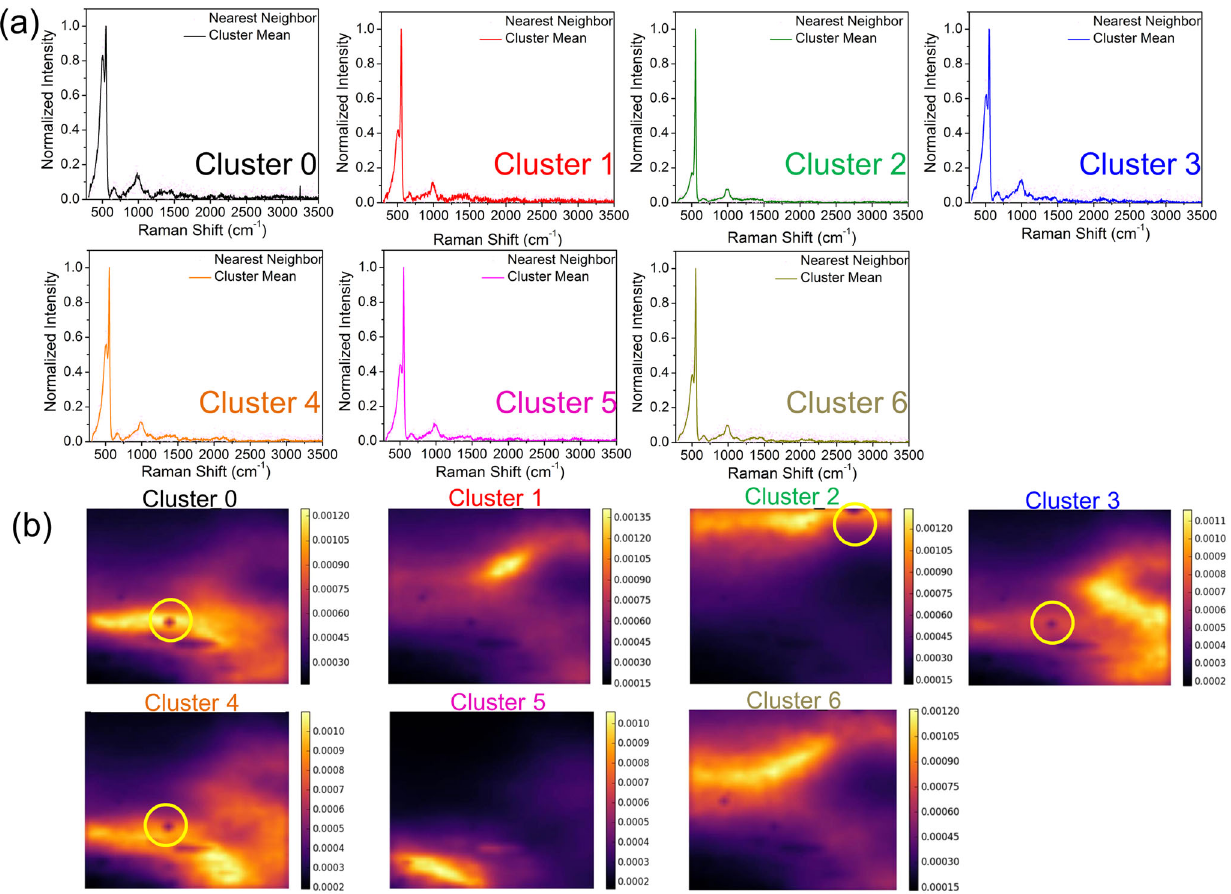
Fig. 4 Viability evaluation of TERS spectral clustering by the multiresolution manifold learning algorithm and the similarity loading. a Average tip-enhanced Raman spectroscopy (TERS) spectrum of each cluster and its nearest neighbor in experimental data. b Similarity loading of each cluster. The color bar represents the reciprocal of Euclidean distance between the mean TERS spectrum and the as-taken TERS spectrum of each pixel within a given